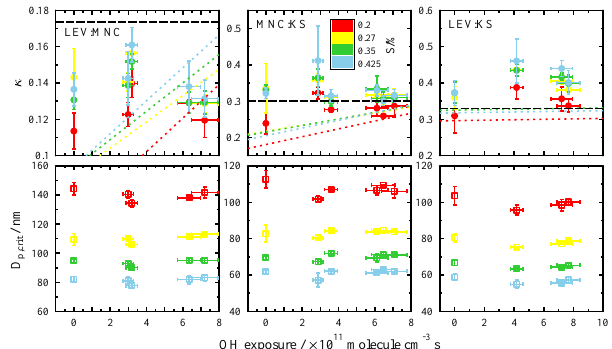
Figure 7. Derived κ (top) and critical particle diameter (bottom) for the binary-component particles with 1 : 1 mass ratios are shown as a function of OH exposure. As indicated in the legend, the col- ors represent the different supersaturations ( S ) accessed during this study. Error bars are calculated as in Fig. 6. The dotted lines are modeled κ using the volume mixing rule as a function of OH ex- posure applying the linear fit to the derived κ of pure MNC and LEV as a function of OH exposure (Fig. 6). The dashed black lines are the modeled κ using the volume mixing rule and assuming no solubility